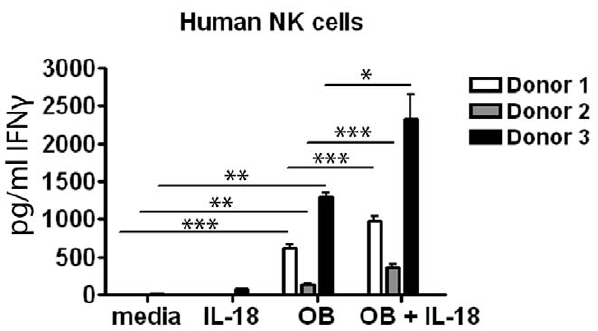
Figure 8. Oenothein B directly primes purified human NK cells to produce IFN c . Human NK cells (5 6 10 4 cells/well) were sorted and treated with 20 m g/ml oenothein B, 100 ng/ml rhu IL-18, both, or medium alone. After 24 hrs, soluble IFN c was measured by ELISA. The graph represents soluble IFN c levels in culture supernatant fluids from three separate experiments with three different donors. Error bars indicate SEM. Each sample was analyzed in triplicate. Significance was determined by One-way ANOVA with Bonferroni post-test. *p , 0.05, **p , 0.01, ***p , 0.001.